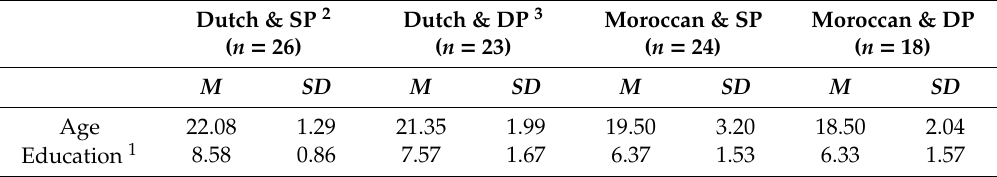
Table 1. Means and standard deviations for participants’ age and education in Study